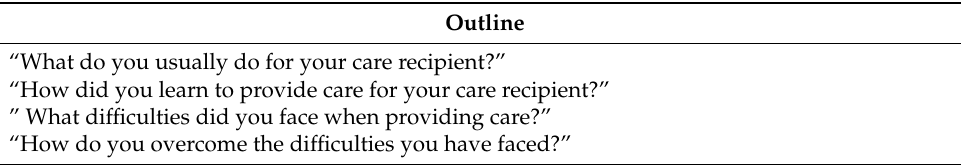
Table 1. Semi-structured interview guide.